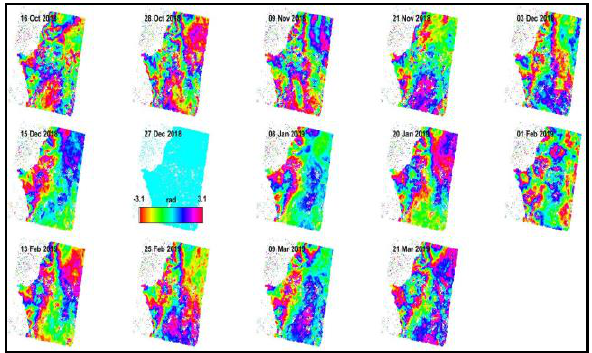
Figure 13. Filtered phases of SAR data used in PSI technique.